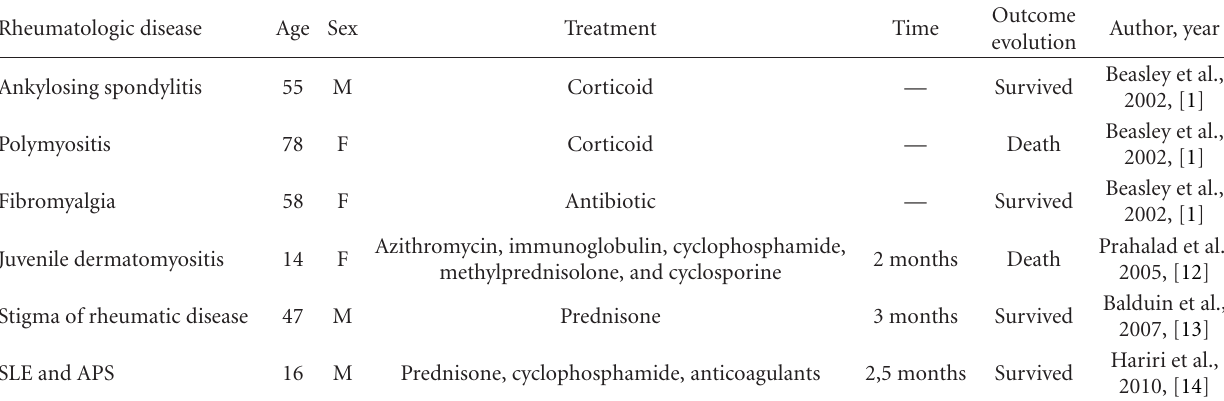
Table 1: Described cases of acute fibrinous organizing pneumonia, 2002–2011.